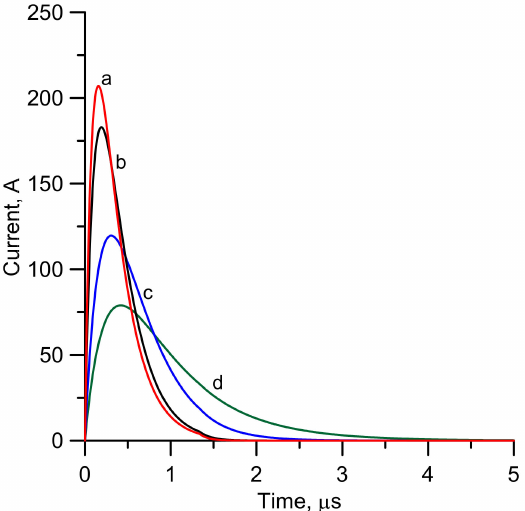
Figure 15. The current at the strike point of a 10-cm long spark for different conductivities of water. ( a ) 10 S/m, ( b ) 5 S/m, ( c ) 2 S/m, and ( d ) 1